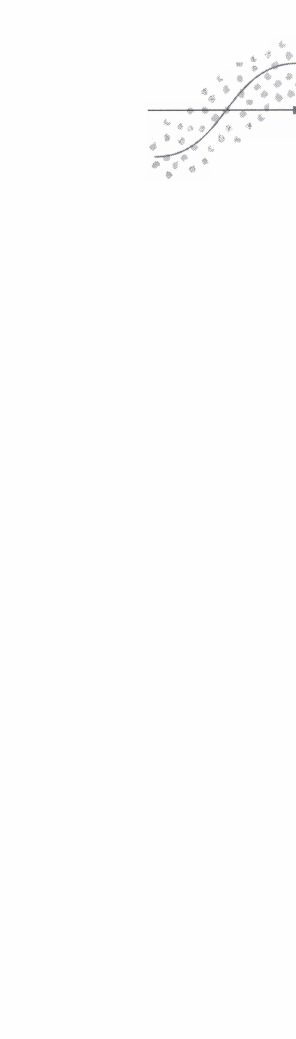
Fig. 6: Equilibrium and structure flow functions of protein foam (mixture II - 10 %